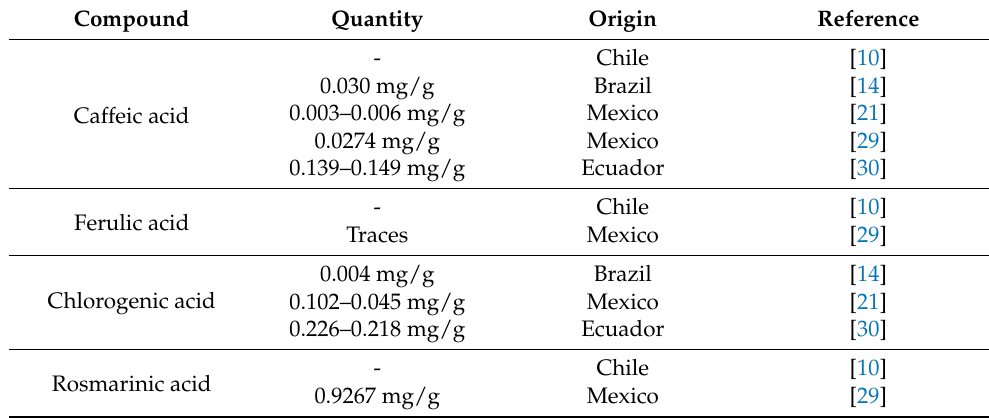
Table 5. Phenolic compounds of chia